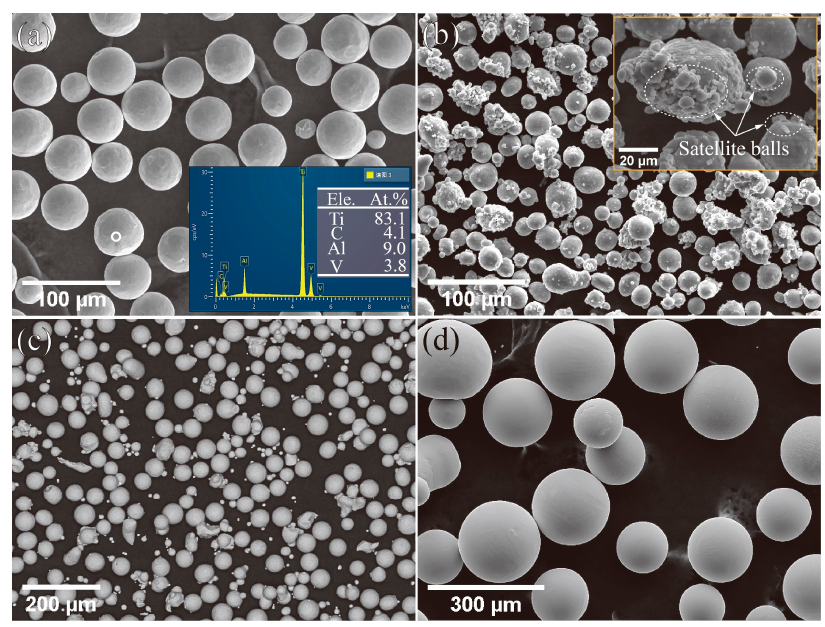
Figure 3. SEM image of #1 Ti64 powders ( a ), #1 Al powders ( b ), #2 Ti64 powders ( c ), and #3 Ti64 powders ( d ).